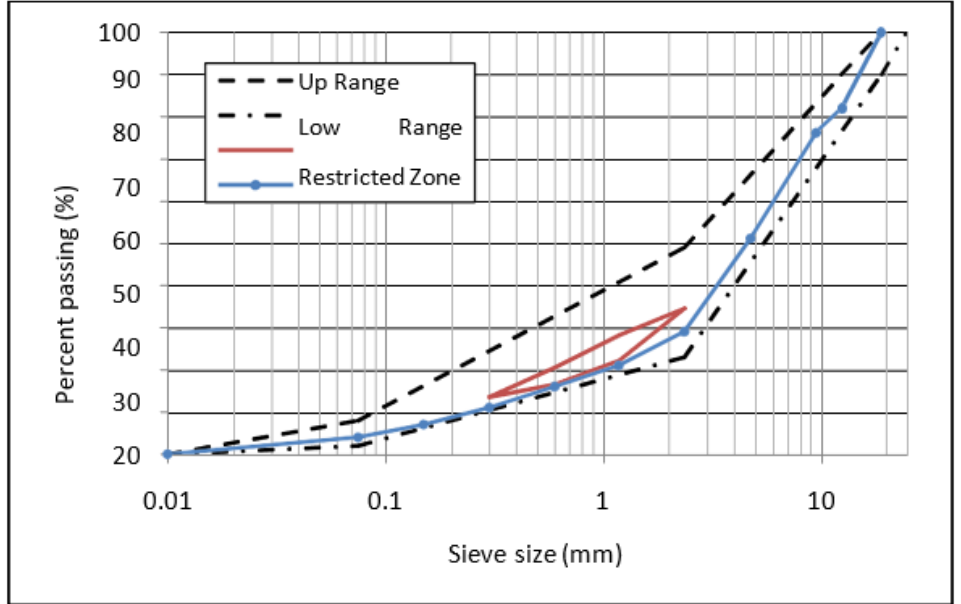
Figure 1. Aggregate gradation.